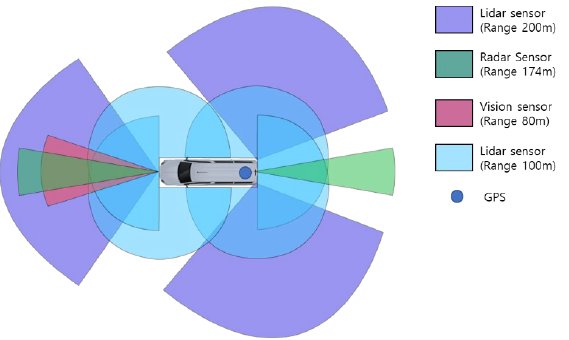
Figure 6. Sensor configuration of connected and automated vehicles for the experiment.